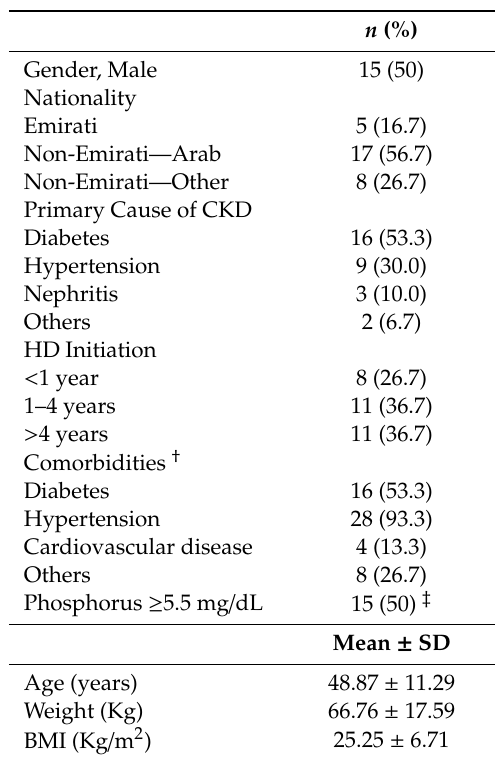
Figure 1. Attrition rate of the study. Table 1. Baseline Characteristics of patients ( n =